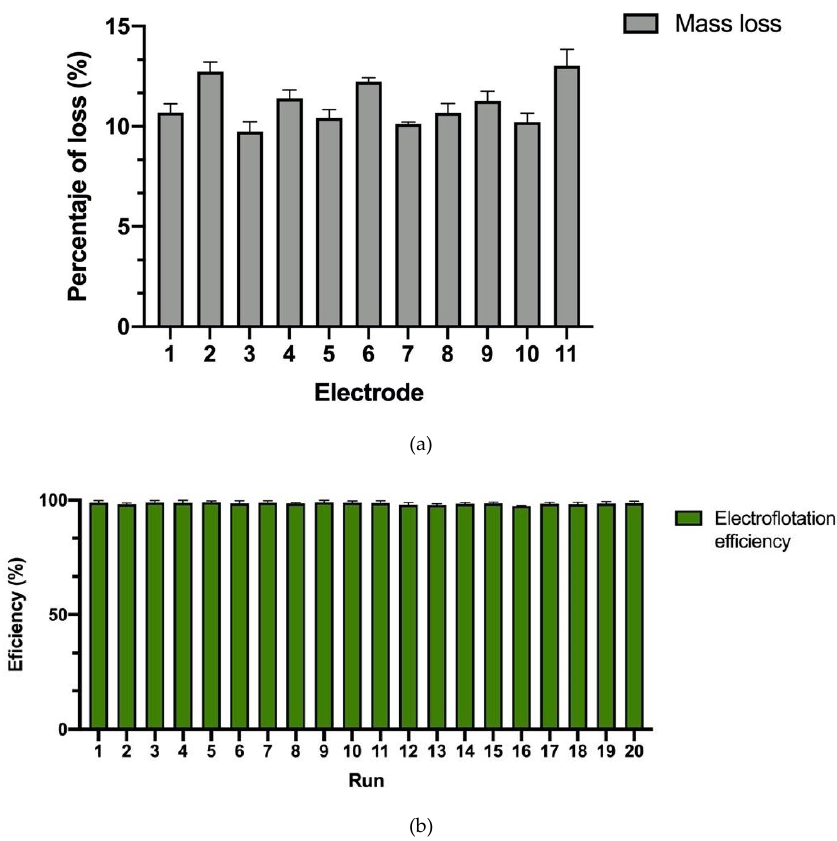
Figure 4. Mass loss of the electrodes ( a ) and efficiency of electroflotation by the reuse of electrodes ( b ).